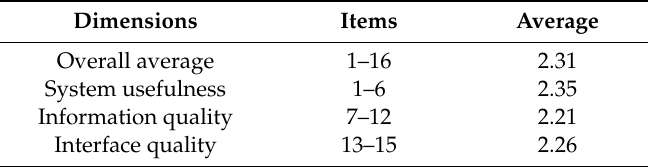
Figure 15. The average score for all items in PSSUQ. Table 1. Average score of the PSSUQ in four